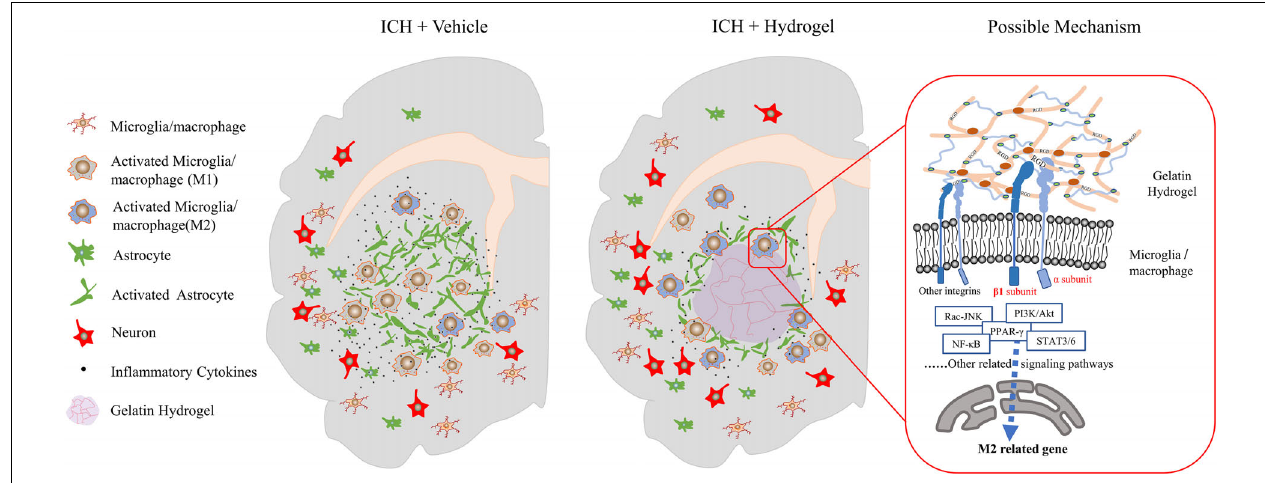
FIGURE 9 | Schematic presentation of the effect of the injectable gelatin hydrogel on the host cells and proposed mechanism.